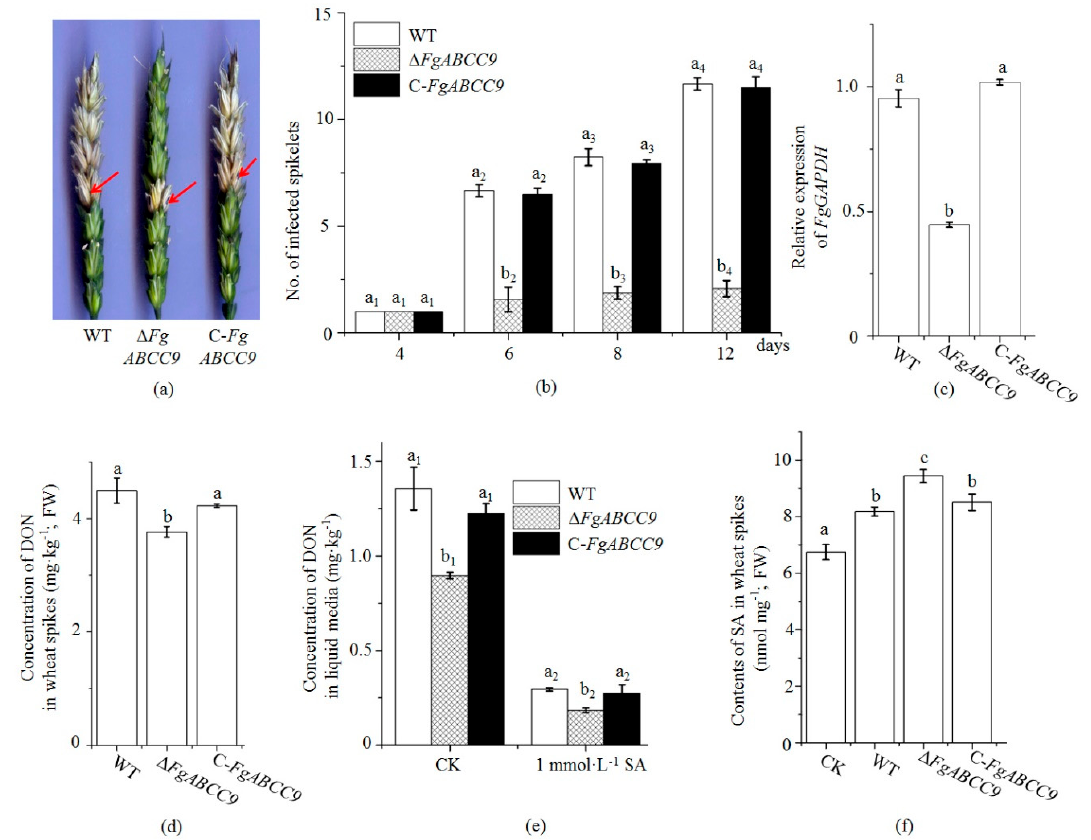
Figure 3. FgABCC9 affected pathogenesis of F. graminearium in spikes. ( a ) FHB disease in wheat heads photographed on the eighth day after inoculation. Arrows indicate the inoculated spikelets. ( b ) the numbers of infected and bleached spikelets on the fourth, sixth, eighth, and twelfth day after inoculation. ( c ) Relative expression level of FgGAPDH ( glyceraldehyde 3-phosphate dehydrogenase gene of F. graminearium , FG05_06257 ) in wheat spikes inoculated with WT, ∆ FgABCC9 , and C- FgABCC9 , respectively. ( d ) DON contents in wheat spikes. ( e ) Concentration of DON in liquid medium. ( f ) Comparison of the accumulation of SA in wheat spikes after inoculation. Values are the mean ± standard deviation. Different letters above each column indicate a significant difference ( p < 0.05). FW, fresh